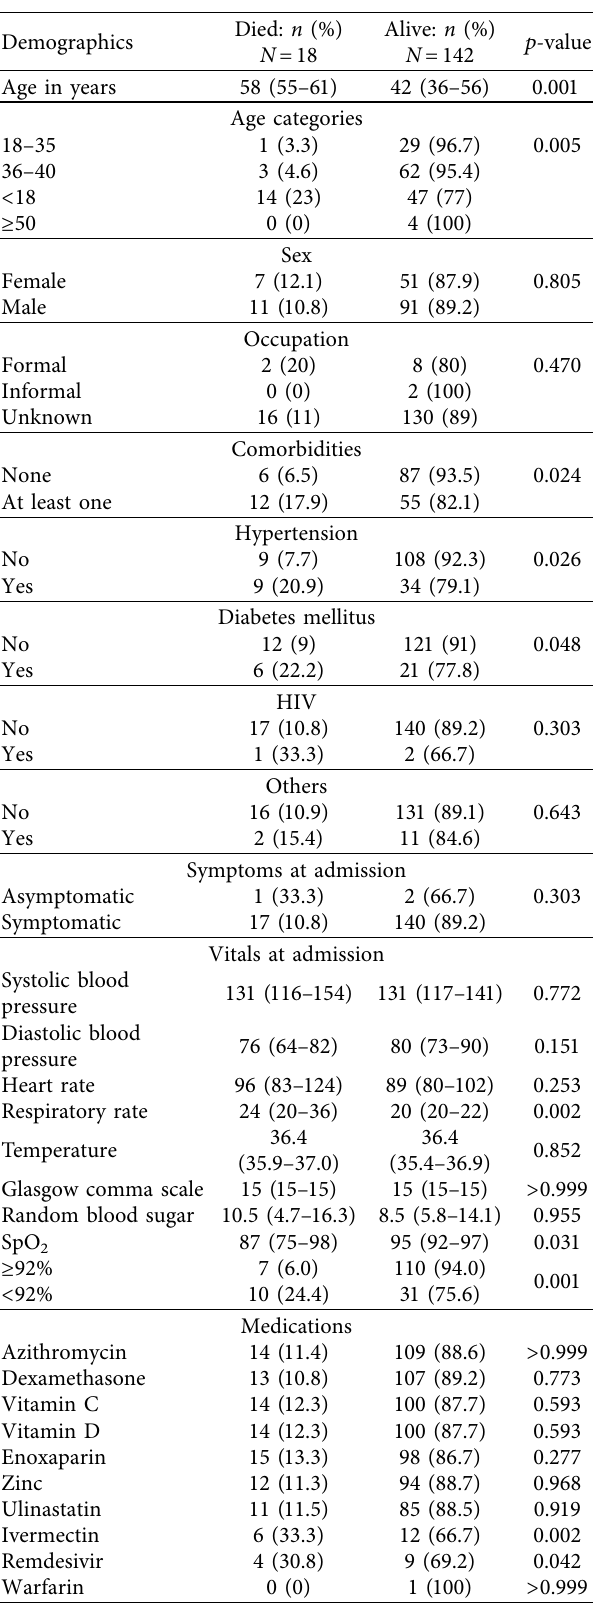
Table 4: Distribution of mortality across patient demographics, admission vitals and medications administered to patients with COVID-19 at case